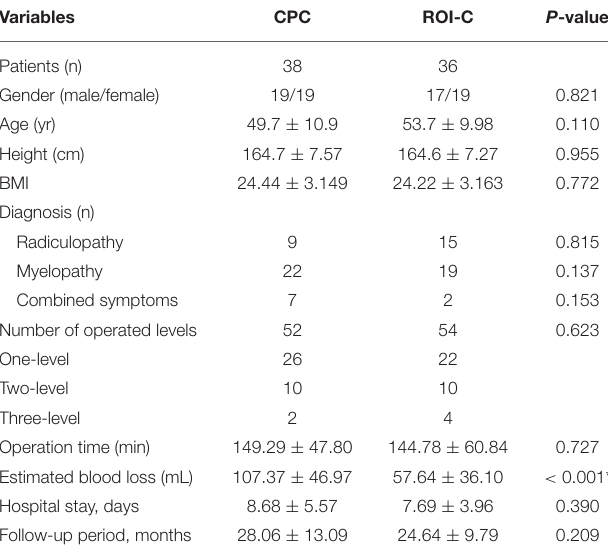
TABLE 1 | Summary of preoperative and operative details. TABLE 2 | Clinical outcomes between ROI-C and CPC group. Variables ROI-C CPC